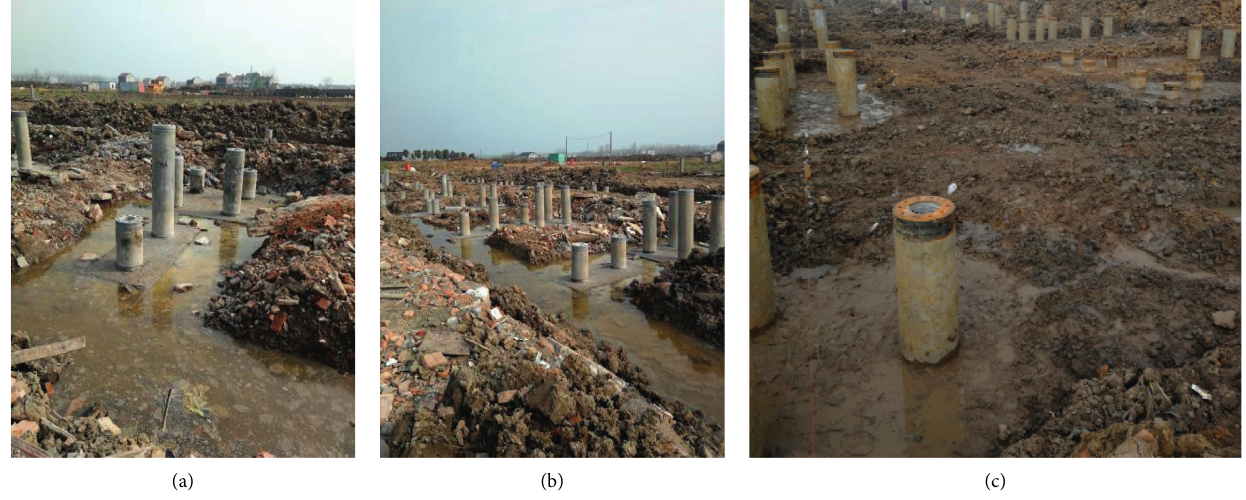
Figure 1: The buried depth of piles in the site varied